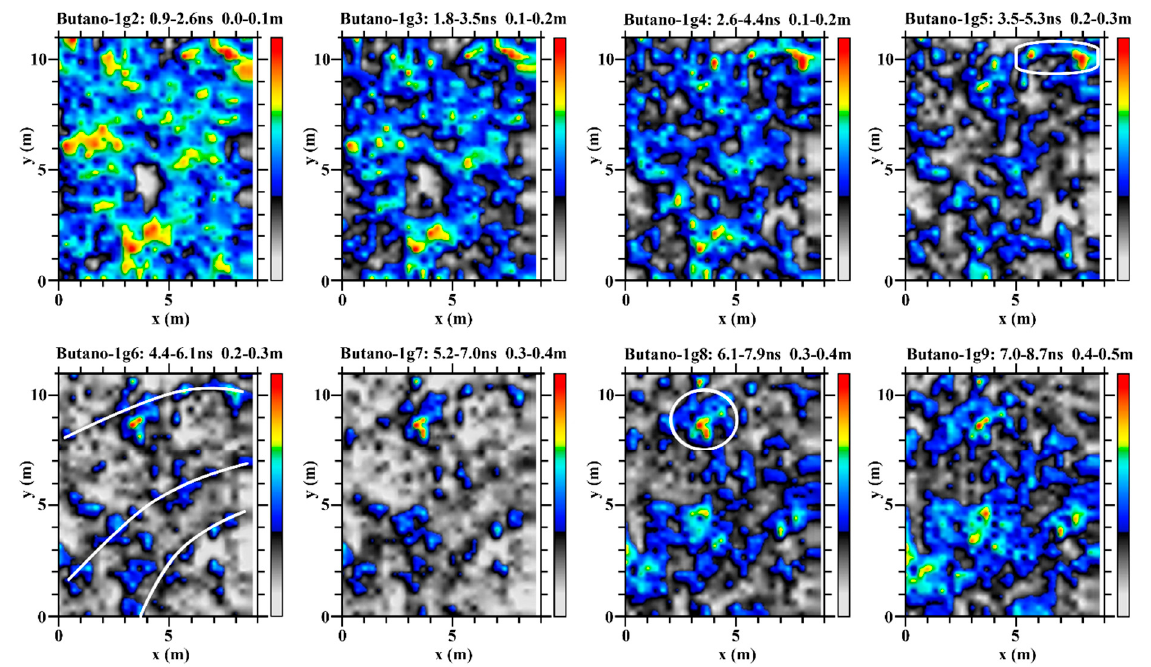
Figure 4. Ground-penetrating radar depth slice comparisons for grid 1. Scale represents the gains-adjusted amplitude time slice parameter for 32-bit data.